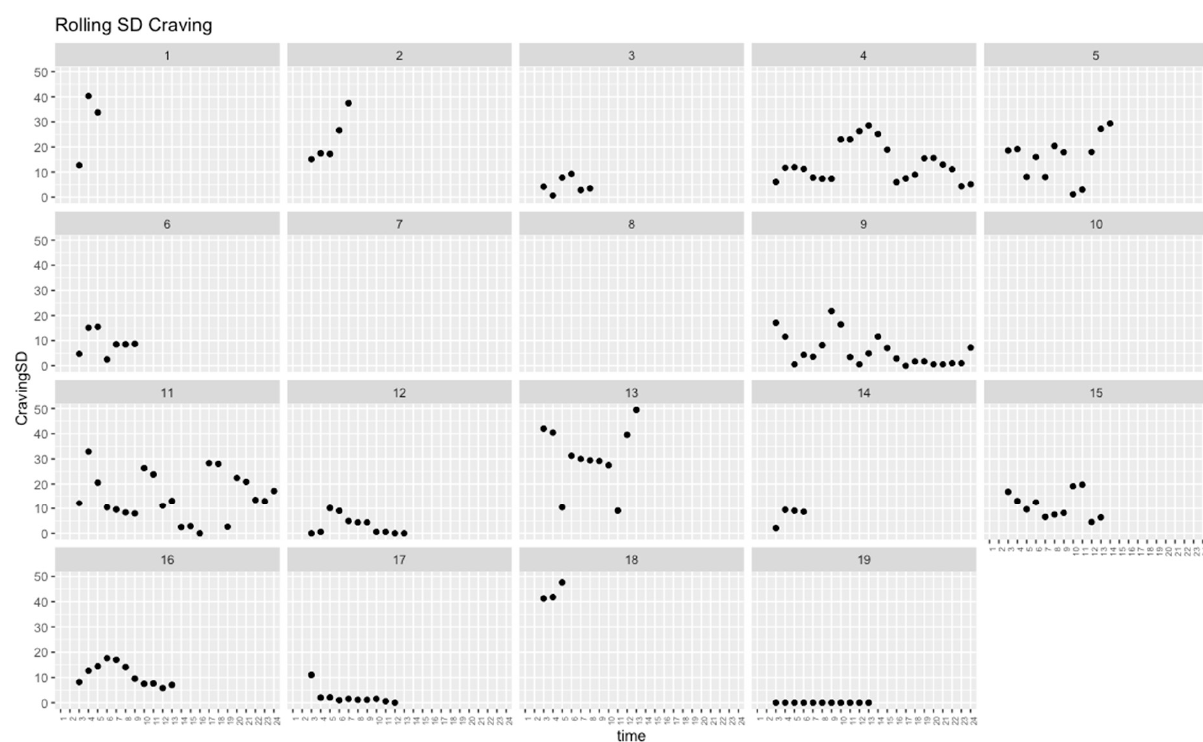
Figure A2. Rolling SD of Craving values per session (time) for all subjects.